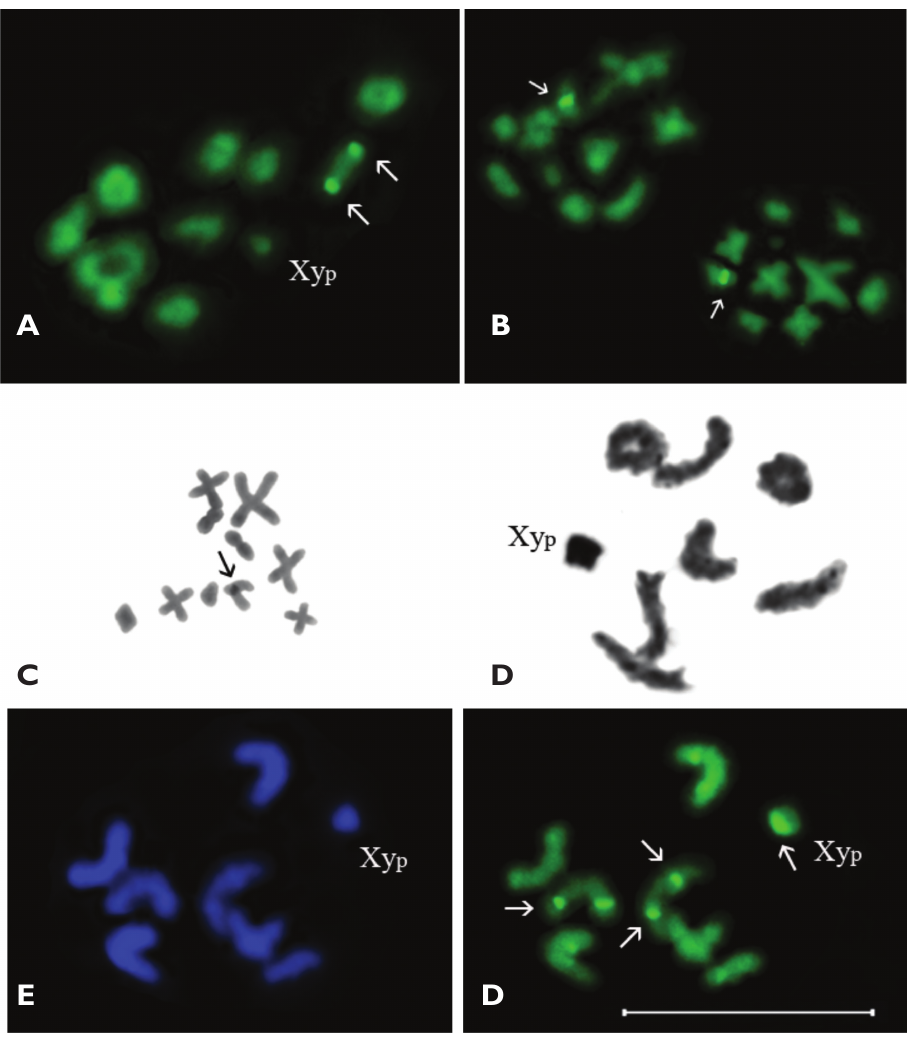
Figure 3A–F. A–C Dicerca aenea validiuscula , A diakinesis/prometaphase I (CMA phase II (CMA staining) C metaphase II (C-banding) D–F Sphaerobothris aghababiani , n=7AA+Xy 3 D diakinesis/prometaphase I (Ag-banding) e metaphase I (DAPI staining) F metaphase I (CMA ing). Bar = 10